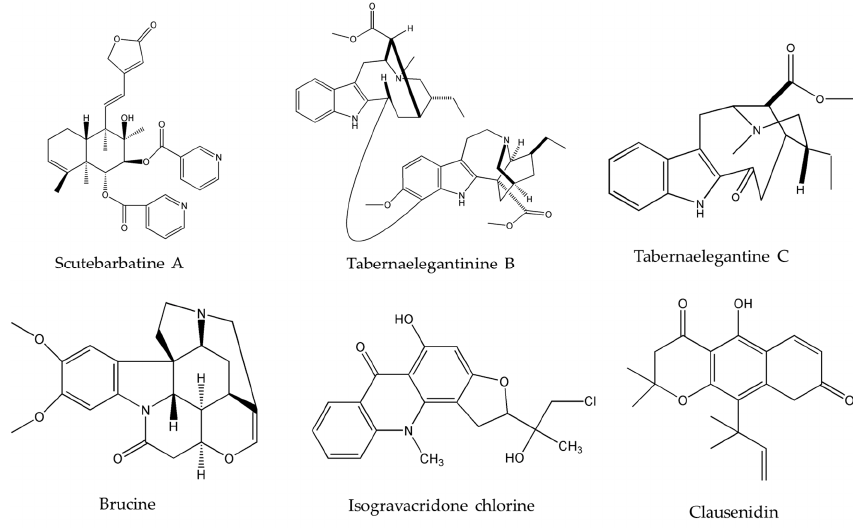
Table 2. Emerging DNA damaging plant-derived